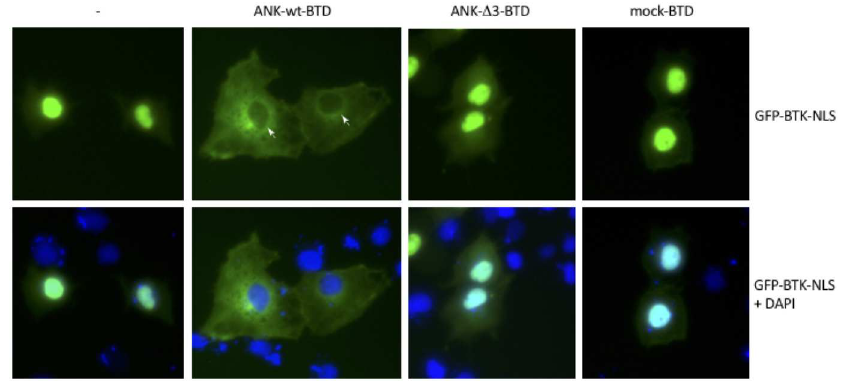
Fig 3. Nuclear exclusion of BTK-NLS fusion protein by ANKRD54. Subcellular localization of pEGFP-BTK-NLS alone(from left to right) and in the presenceof wild-typeANKRD54, Δ 3-mutant and mock. The white arrowheads in the second upper panel indicatenuclei devoid of BTK-NLS and the lower panels indicatemerged images.